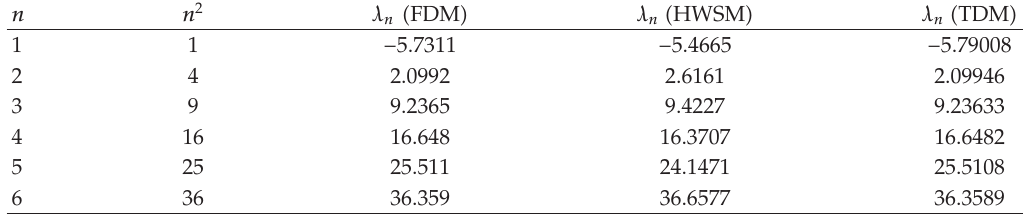
Table 6: Comparison of higher eigenvalues for Mathieu’s equation obtained from FDM, HWSM, and TDM corresponding to θ (cid:5) 5.